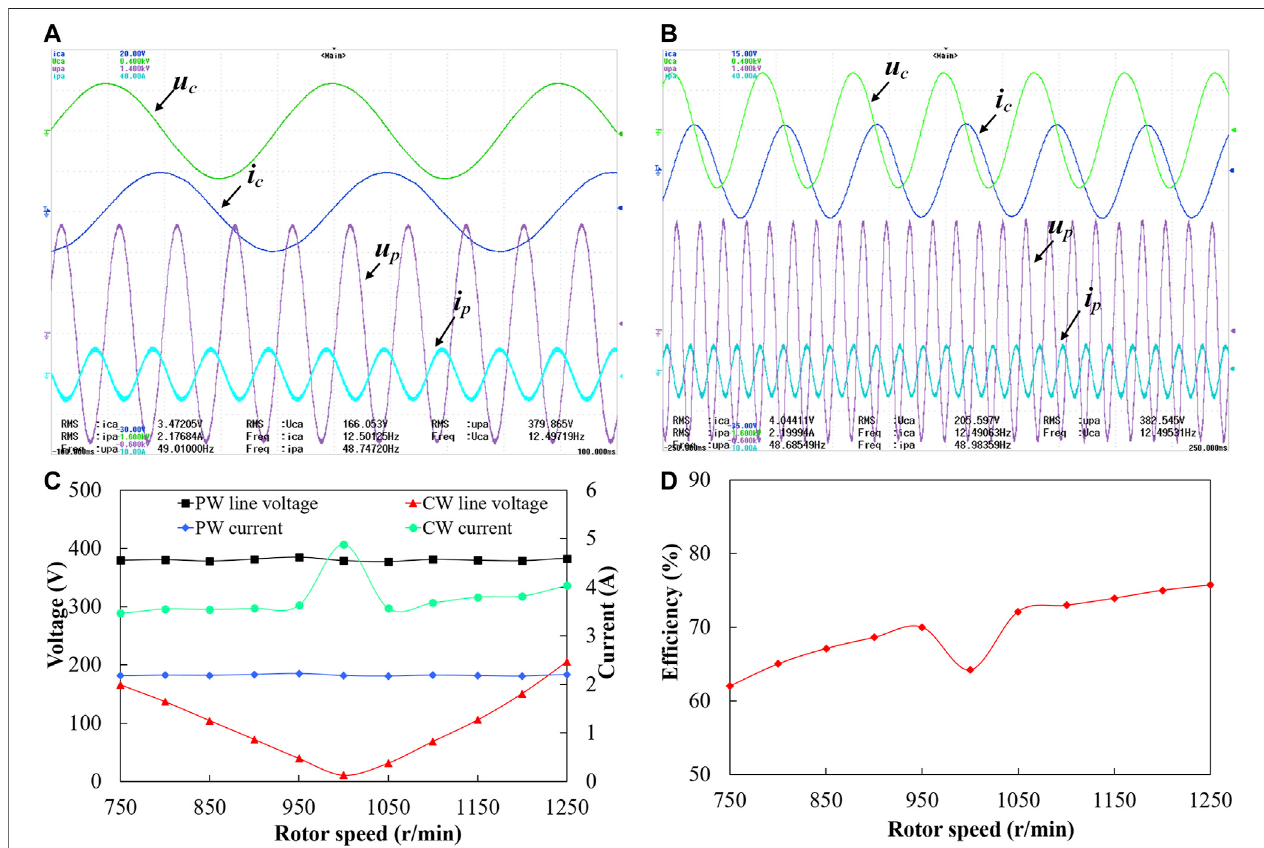
FIGURE 10 | Experimental measurement of CW voltages, CW currents, PW voltages, PW currents, ef fi ciencies from 750 r/min to 1,250 r/min (A) 750 r/min (CW -12.5 Hz, PW 50 Hz and 20 ms/div) (B) 1,250 r/min (CW 12.5Hz, PW 50 Hz and 50 ms/div) (C) 750 r/min to 1,250 r/min (D) Ef fi ciencies versus rotor speeds.